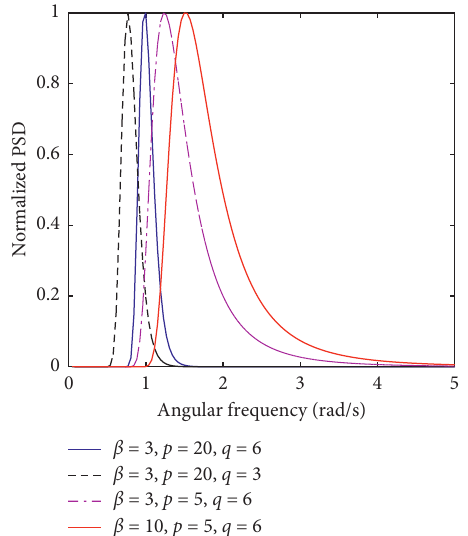
Figure 4: Normalized power spectrum density with various parameters of β , ρ , and q